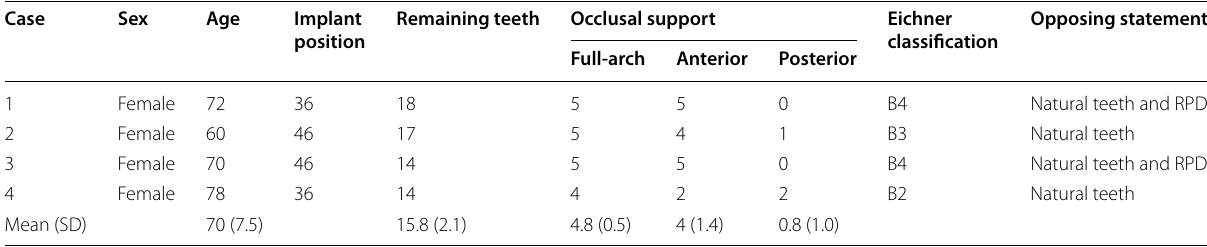
Table 1 Characteristics of